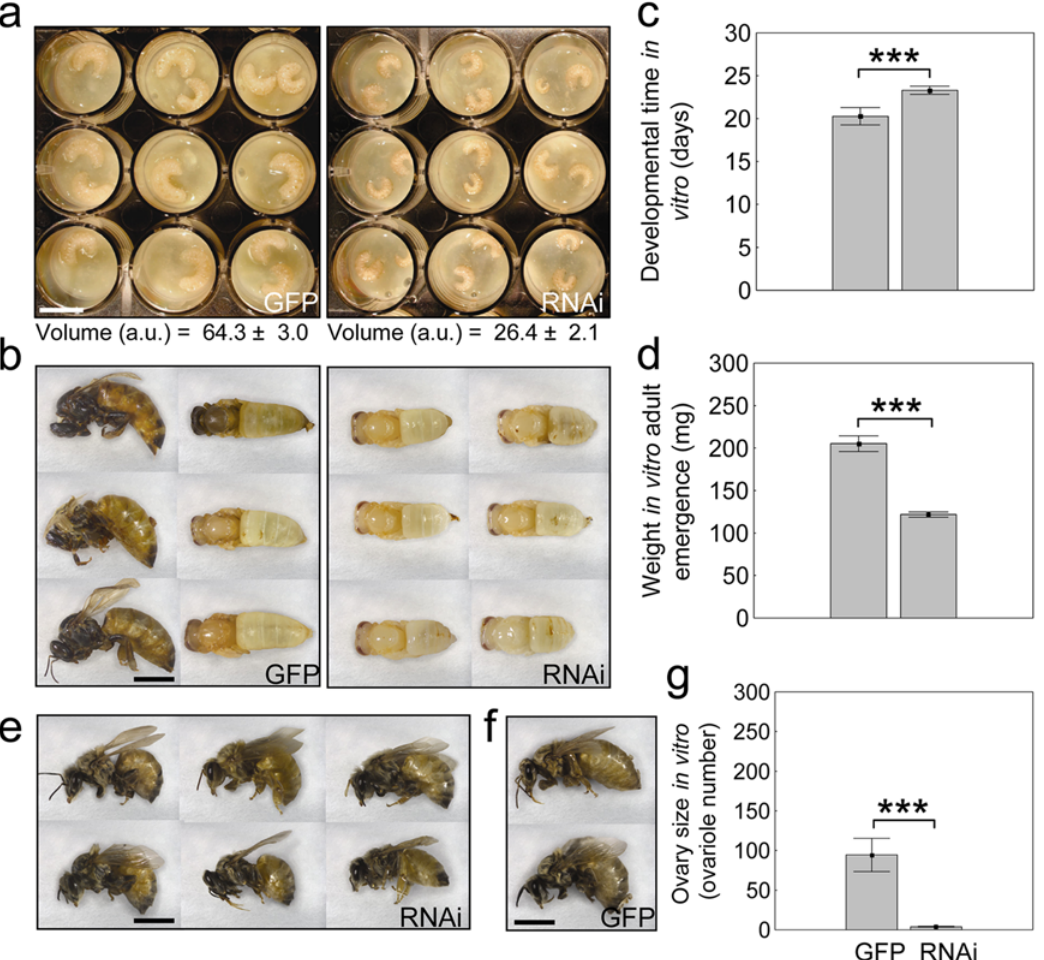
Figure 3. Effect of amTORsuppression on caste characters in honey bees. In comparison to control (GFP), amTOR RNAi (RNAi): a, reduced larval growth (exemplified by 4-day-old larvae in sections of a microtiter plate, larval volume is mean 6 s. e. arbitrary units a.u.); delayed development, b–c, where b is a snapshot of the full phenotypic variance in each group (individuals were 19 days old) – controls emerged with queen morphology, or had advanced pigmentation (indicates more rapid development) and large size. RNAi bees were lightly pigmented and small in size; the latter effect is shown also in d, the wet-weight at adult emergence and in e, the final adult size. Adult size did not overlap between treatment groups (e vs. f, where f shows the two control bees with lowest wet-weight: 155 and 161 mg; weight-range after RNAi was 108–136 mg). amTOR RNAi also reduced ovary size g, to ovariole numbers characteristic of workers (GFP range was 12–180, RNAi range was 2–7 ovarioles per ovary). In sum, the divergence between control and amTOR RNAi is characteristic of queen vs. worker development [5]. Bars are means 6 s. e. (three asterisks P , 1.0 10 2 3 ). Scale bars a: 10 mm; b, e, f: 5 mm.